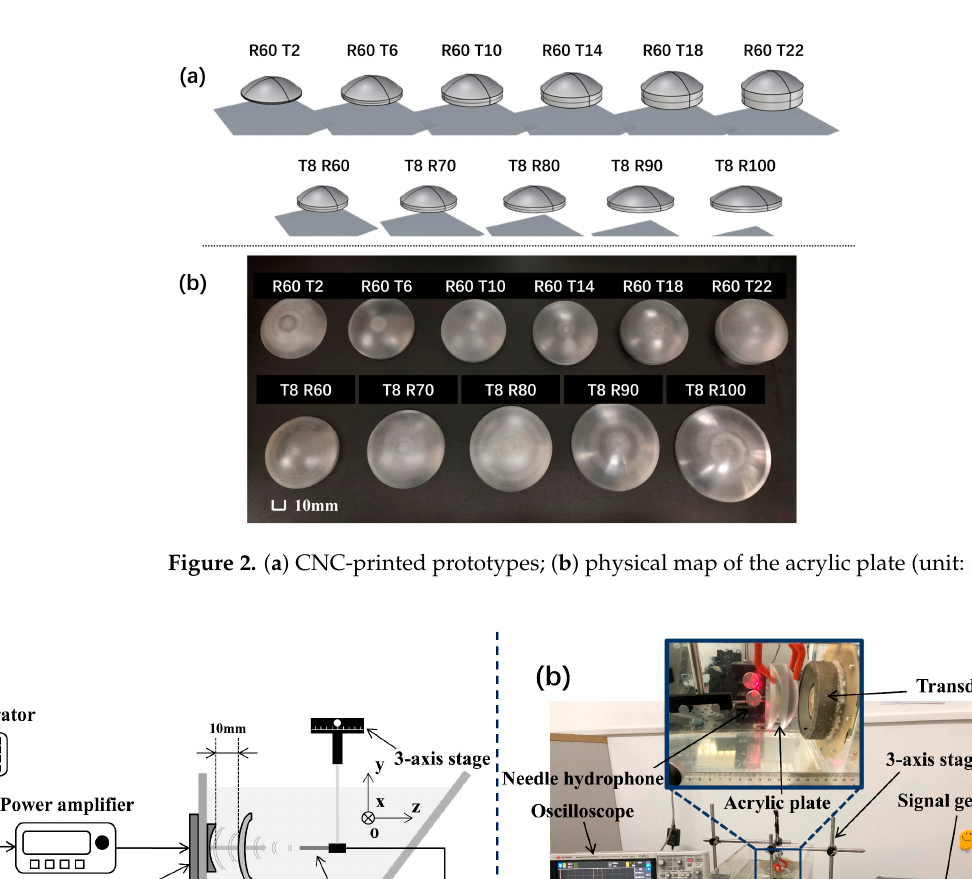
Figure 3. ( a ) Schematic diagram of the experimental setup; ( b ) physical map of the experimental setup.